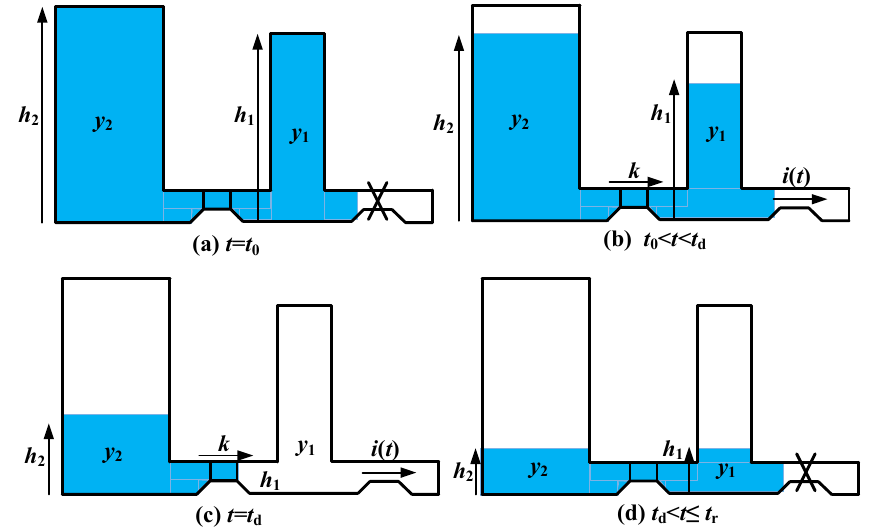
Figure 3. Battery capacity changes with the discharge time in the discharge process.